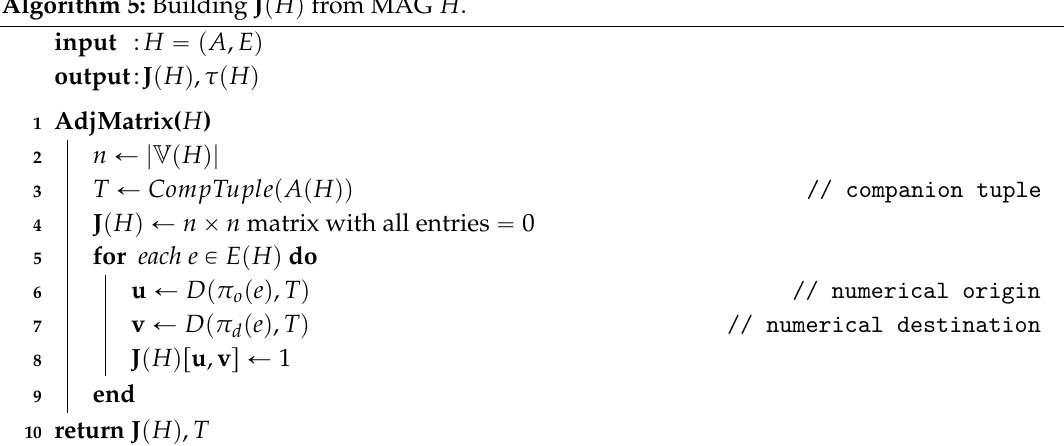
Algorithm 5: Building J p H q from MAG H